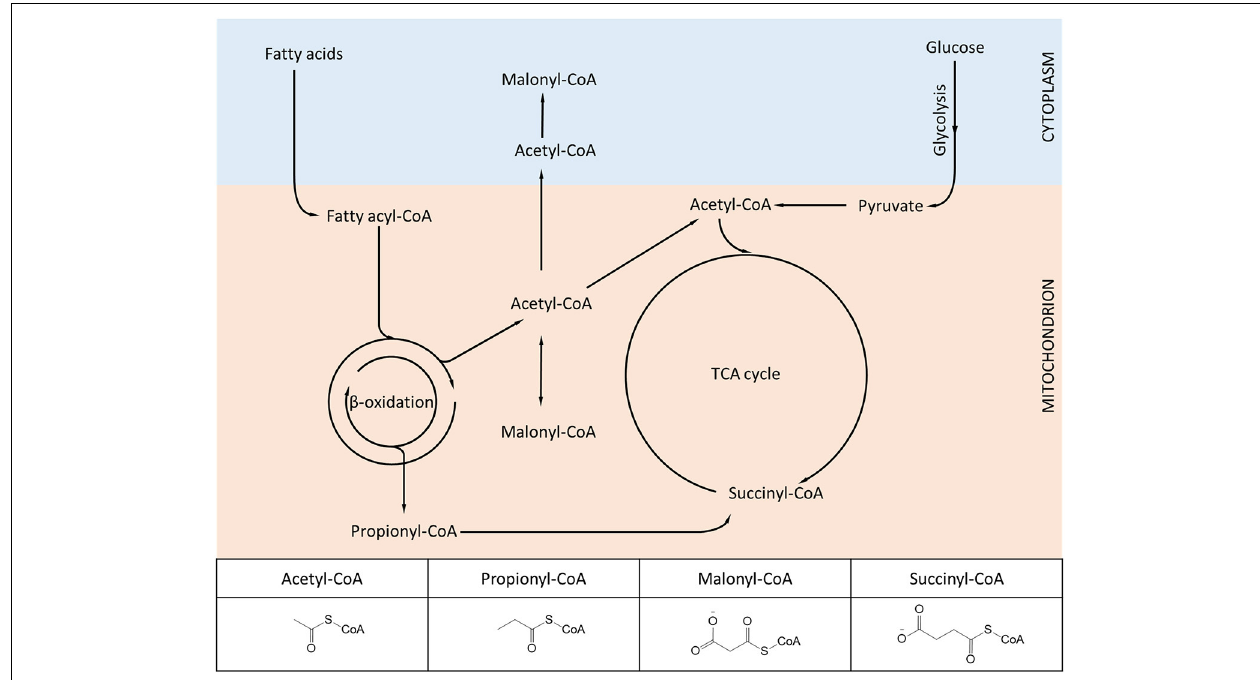
FIGURE 2 | Diagram showing metabolic intermediates produced in mitochondria and utilized in protein lysine modifications. The inset table highlights the structural similarities and differences among the various acyl-CoA species. Lysine acetylation,